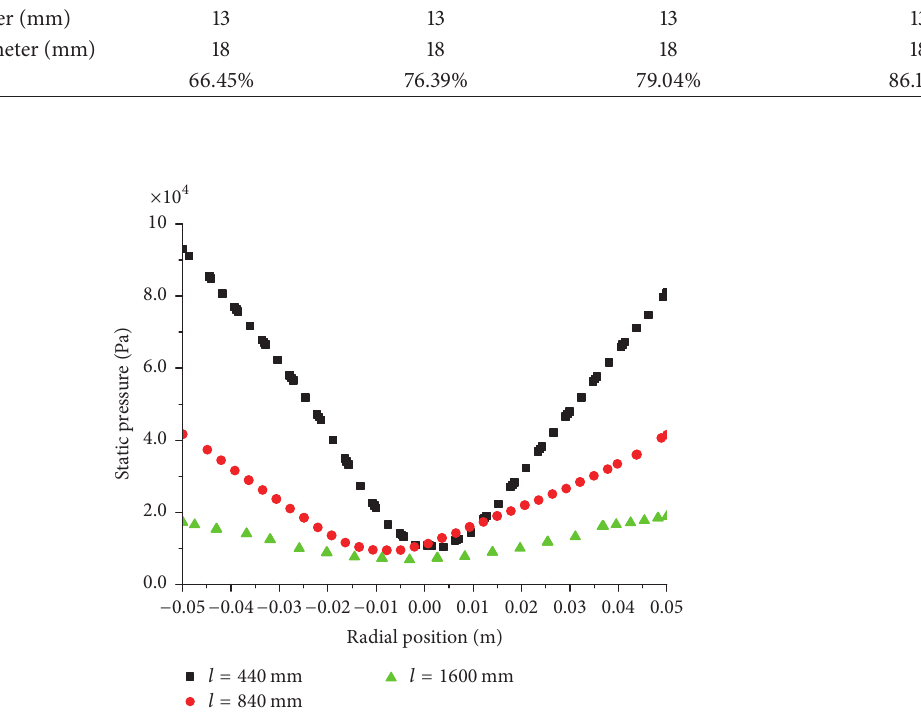
Figure 7: Static pressure distribution on the cross section of the separator middle